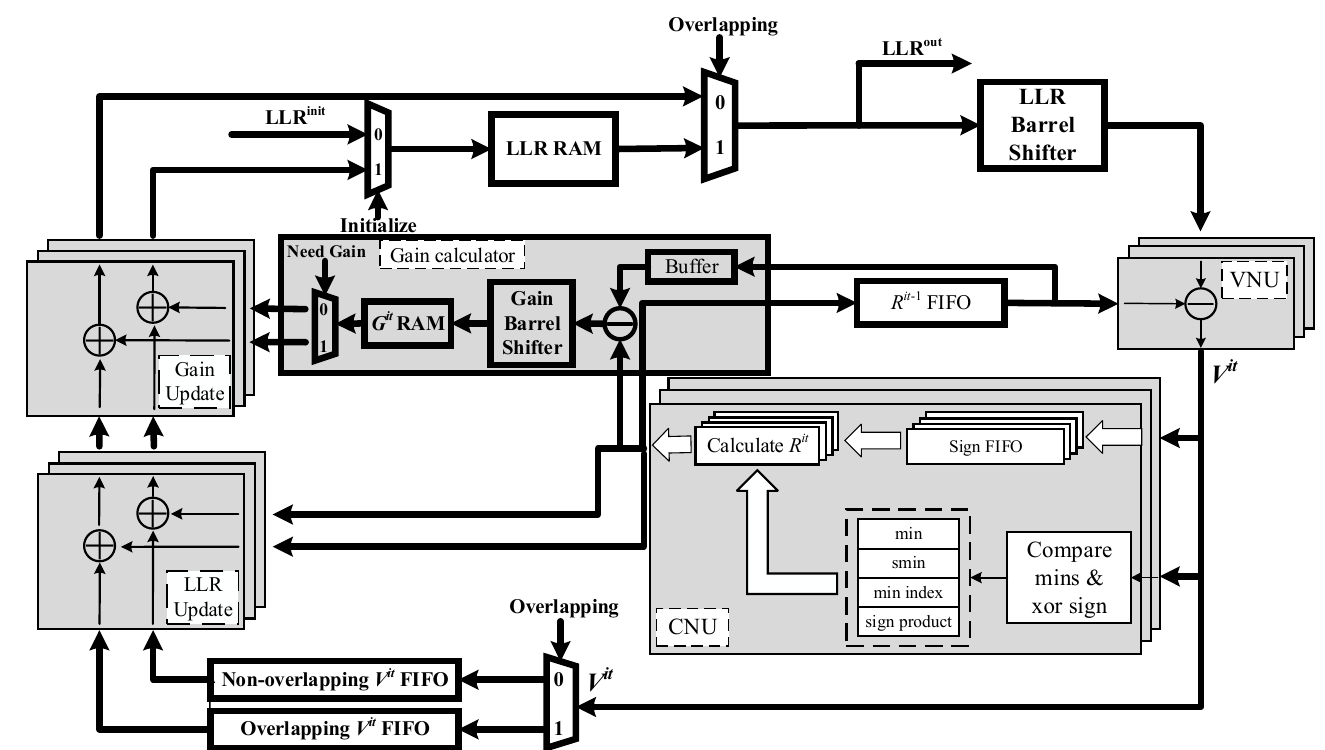
Figure 2. Architecture of the priority-based QC-LDPC decoder with double update queues.